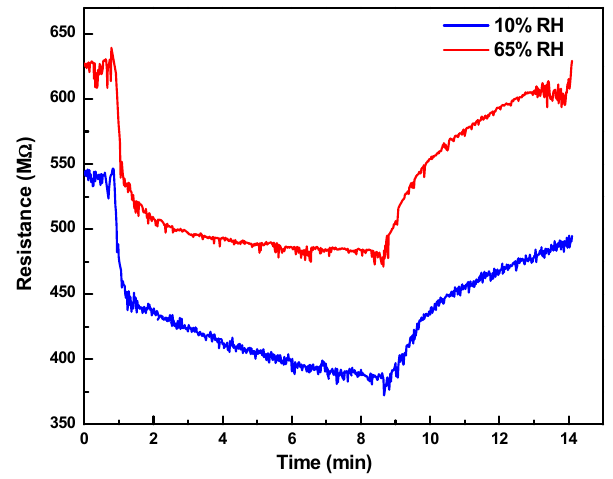
Figure 10. Resistance evolution in presence of 18 ppm H 2 S concentration at different RH.